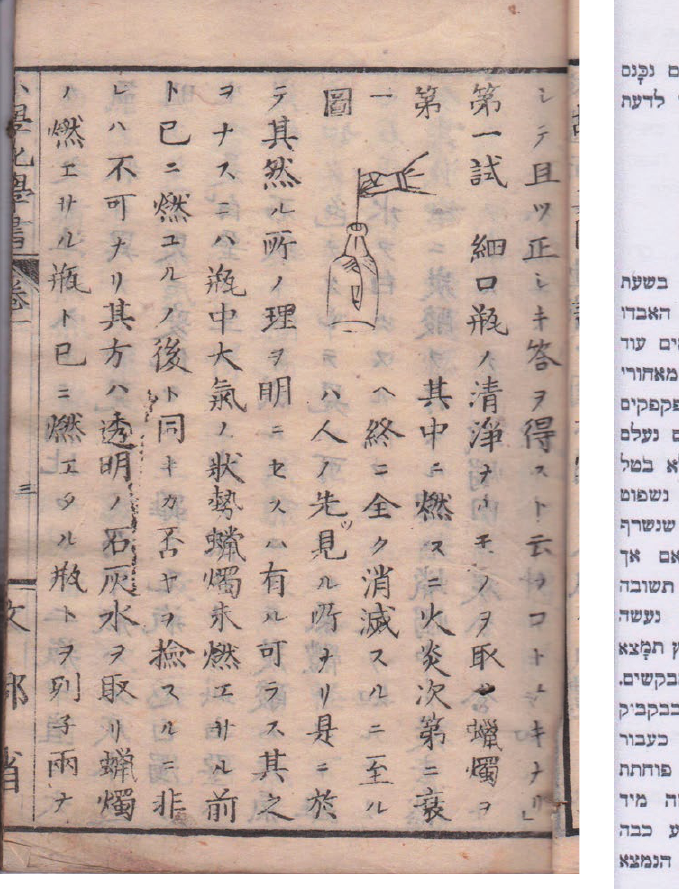
Figure 3. Candle burning experiment in Japanese, 1873.